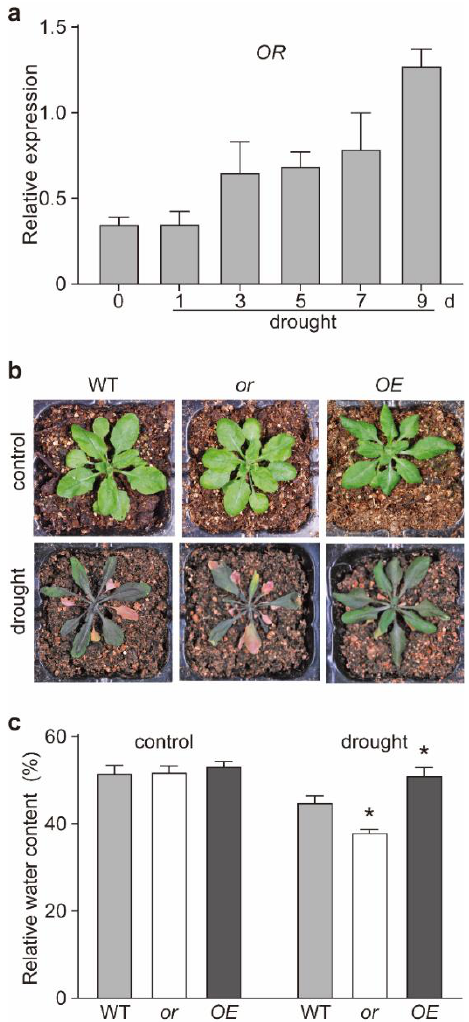
Figure 1. Response of different OR transgenic lines to drought stress. ( a ) Transcript abundance of OR in the wild-type (WT) Arabidopsis thaliana seedlings, before (0) and after different days of drought treatment. Transcript abundance was determined by qRT-PCR, with Actin2 as a reference. Data are means ± SEM ( n = 3). ( b ) Representative seedlings of the WT and OR -overexpressing ( OE ) and -silencing ( or ) of A. thaliana seedlings under normal growth conditions (control) and drought treatment for 15 d. ( c ) Relative water contents in the WT, OE , and or seedlings under normal growth conditions (control) and drought treatment for 10 d. Data are means ± SEM ( n = 3, * p < 0.05, Student’s t test).